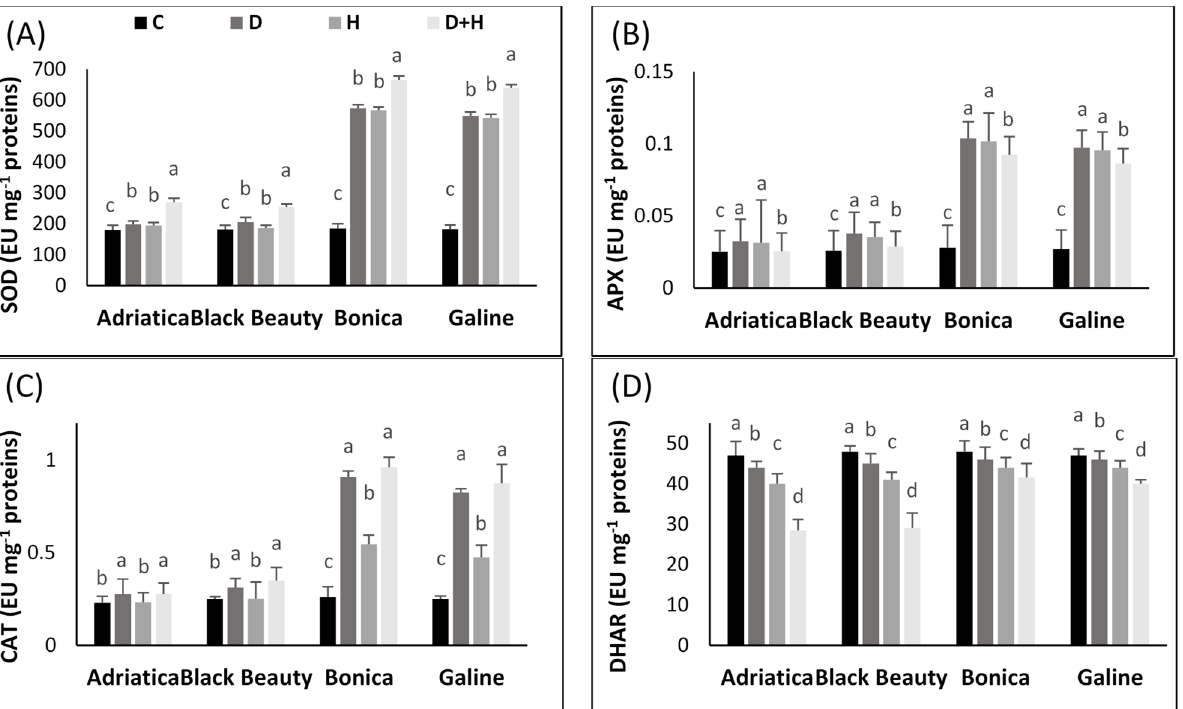
Figure 4. Changes in SOD ( A ), APX ( B ), CAT ( C ), and DHAR ( D ) of four eggplant cultivars under individual and combined stresses. Data presented are the means ± SE ( n = 5). Significant dissimilar- ities are shown by different lower-case letters between treatments p ≤ 0.05 based on Tukey’s test. (C, control; H, heat stress; D, drought stress; H + D, heat + drought stresses).